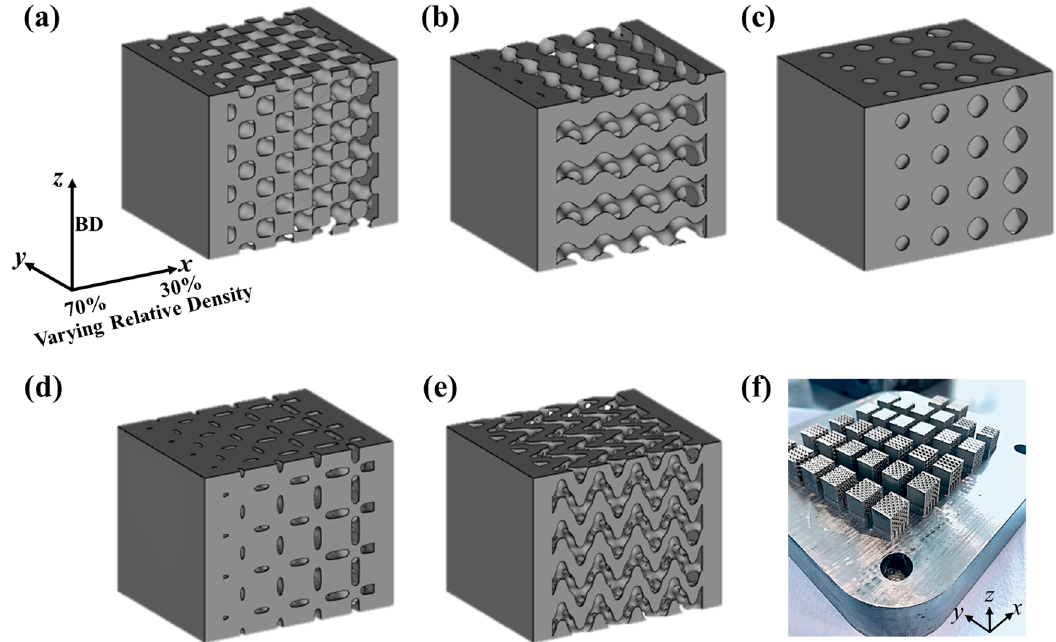
Figure 1. Designed TPMS structures with relative density varying from 30% to 70% and build direction (BD) indicated by the arrow and types: ( a ) Diamond; ( b ) Gyroid; ( c ) Primitive; ( d ) Neovius; ( e ) Fisher–Koch; ( f ) As-built samples on the build plate. ( e ) Fisher–Koch; ( f ) As-built samples on the build